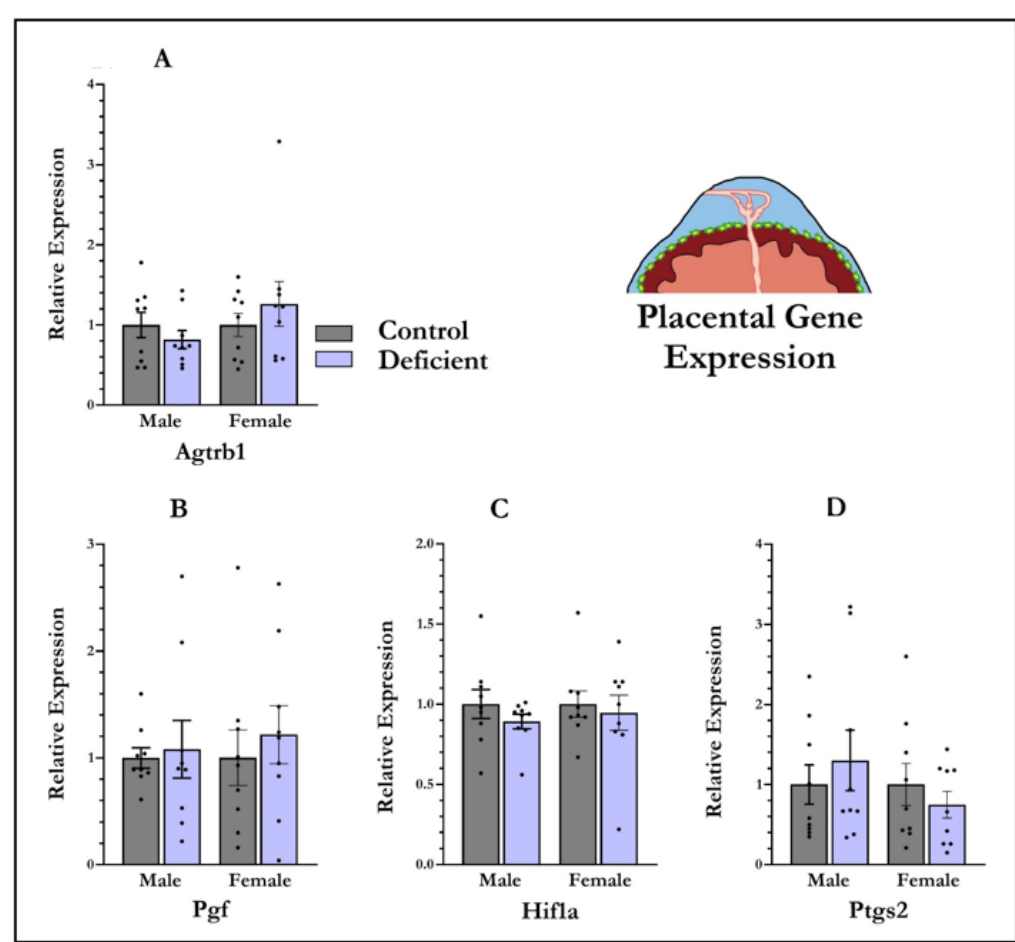
Figure 3. Vitamin-D-deficient pregnant rats do not have alterations in expression of genes central to preeclampsia phenotypes. The mRNA levels were measured at gestational day 19 from placentas collected from both male and female foetuses. No significant effect of diet was observed on type-1 angiotensin II receptor ( Agtrb1 ) ( A ), placental growth factor ( Pgf ) ( B ), hypoxia inducible factor 1 alpha ( Hif1a ) ( C ), or prostaglandin–endoperoxide synthase 2 ( Ptgs2 ) ( D ). Data shown are means; error bars show SEM; n = 9 control males, n = 9 vitamin-D-deficient males, n = 9 control females, n = 9 vitamin-D-deficient females .